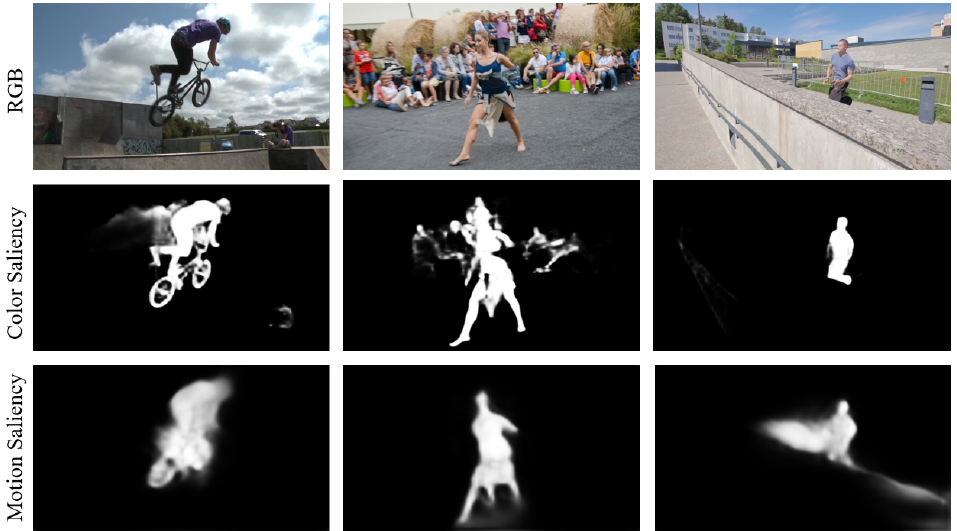
Figure 5. High-quality motion saliency maps and color saliency maps often have higher consistency in